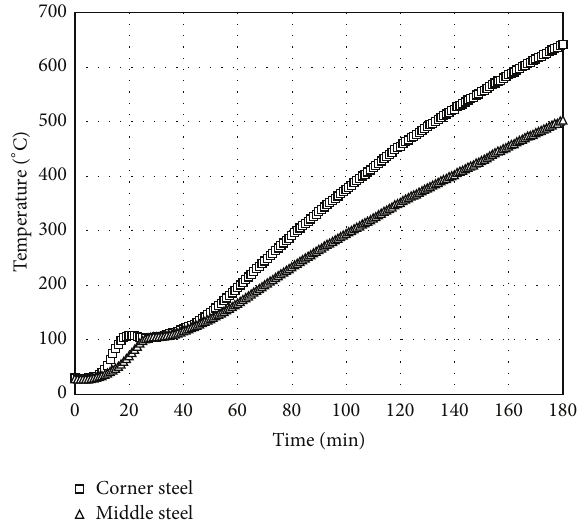
Figure 5: Temperature variations with respect to time in concrete.